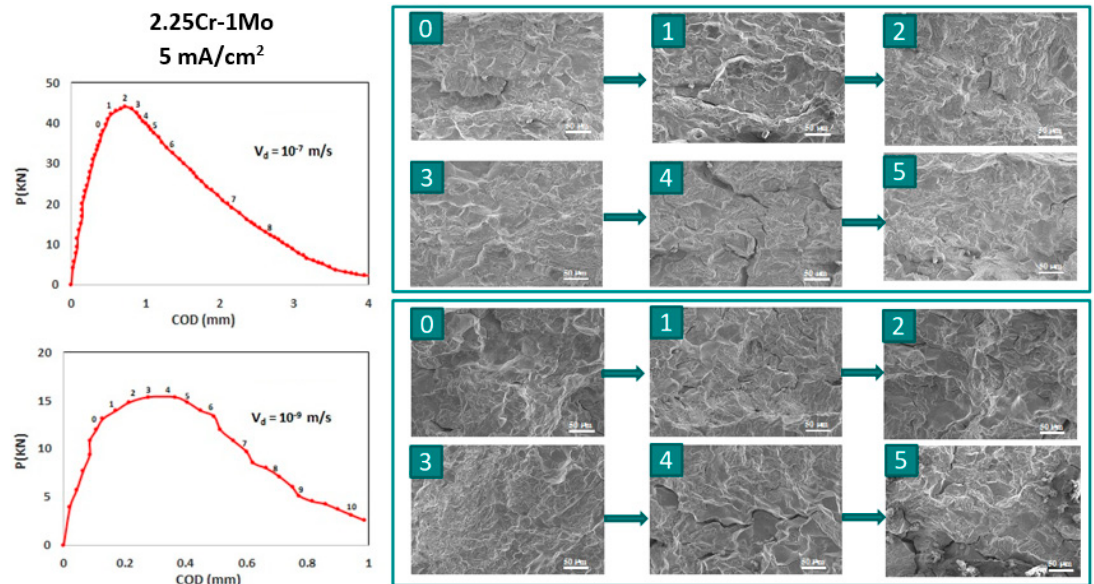
Figure 14. Fractographic images corresponding to different stages of P-COD register from the slow